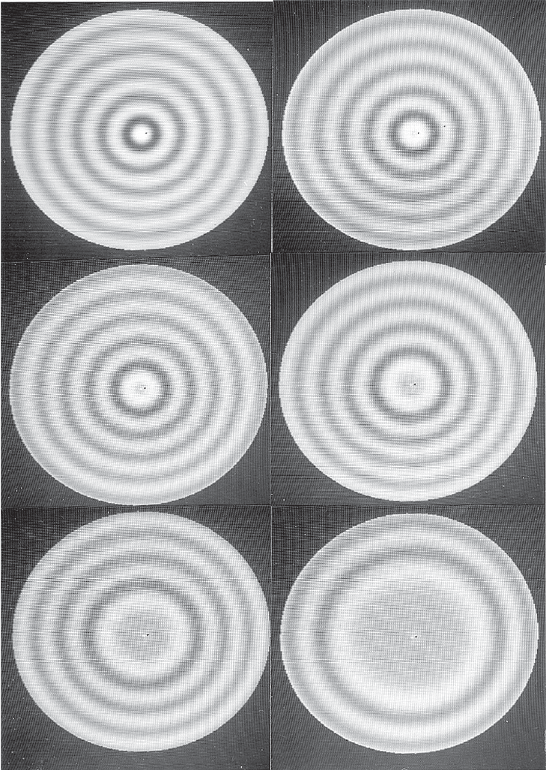
Figure 4. Photographs of spherical Bessel functions, j n (µ), for n = 0, n = 4 and n = 8 (top, center, bottom) at µ = 0.5 (left) and 3.0 cpd (right) as originally calibrated for a 150-cm viewing distance.